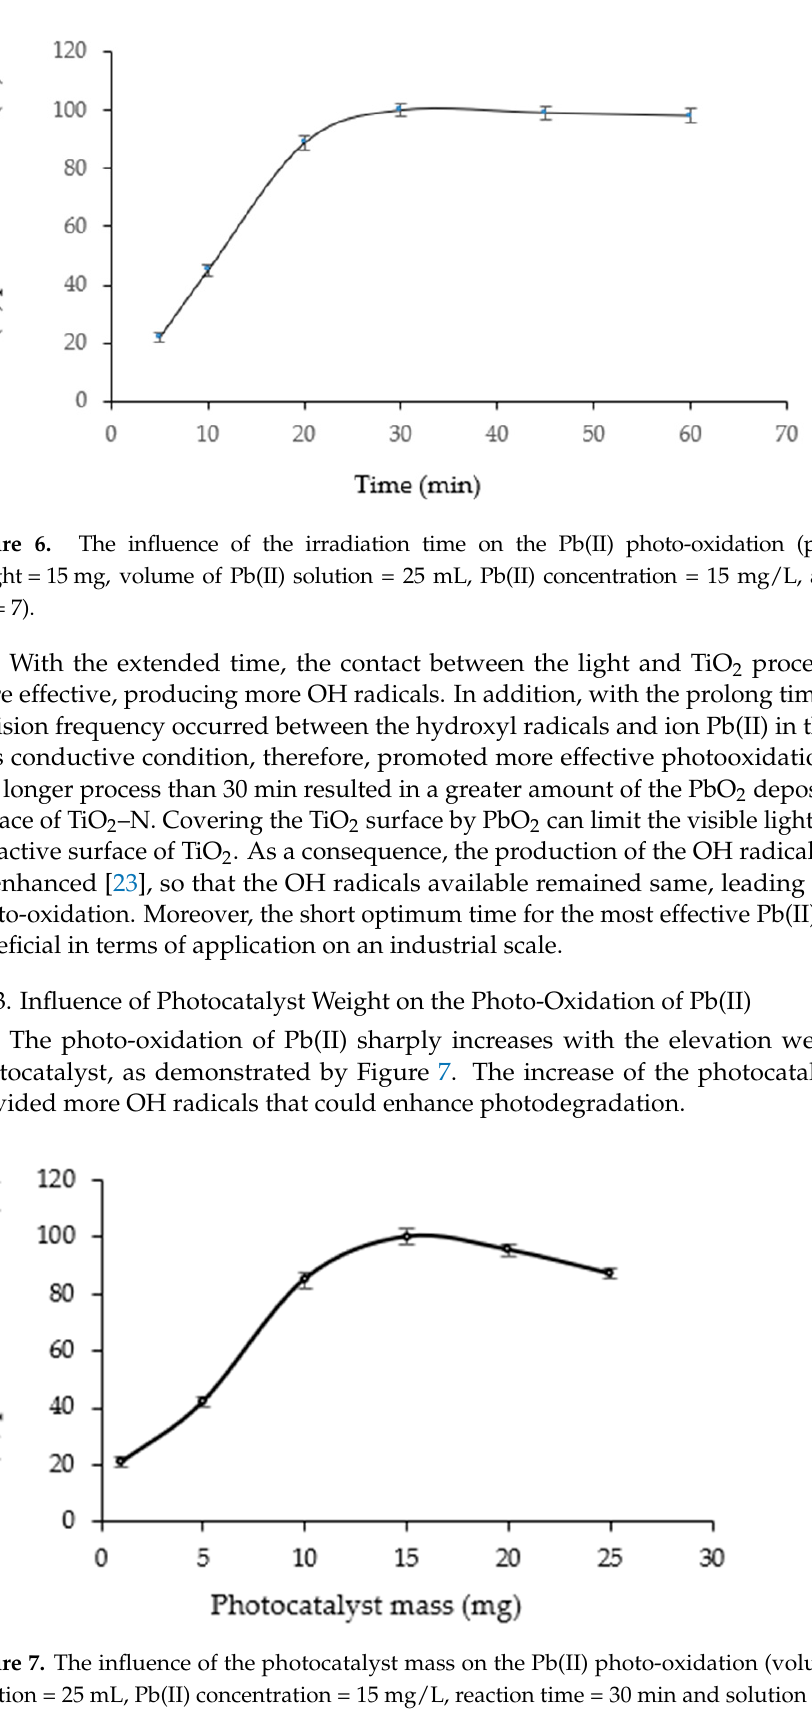
Figure 7. The influence of the photocatalyst mass on the Pb(II) photo-oxidation (volume of Pb(II) solution = 25 mL, Pb(II) concentration = 15 mg/L, reaction time = 30 min and solution pH = 7). This trend data is in perfect accordance with the data resulted by some studies [8,12,14,23]. The larger weight that exceeded the optimum level caused a detrimental in photodegradation. The excessive photocatalyst elevated the turbidity of the mixture that inhibited the light penetration [8,14,23]. The other possible reason is that the large photo- catalyst dose allowed for agglomeration that depleted the active photocatalyst surface; thus, less photo-oxidation efficiency was obtained [12]. The mass producing maximum